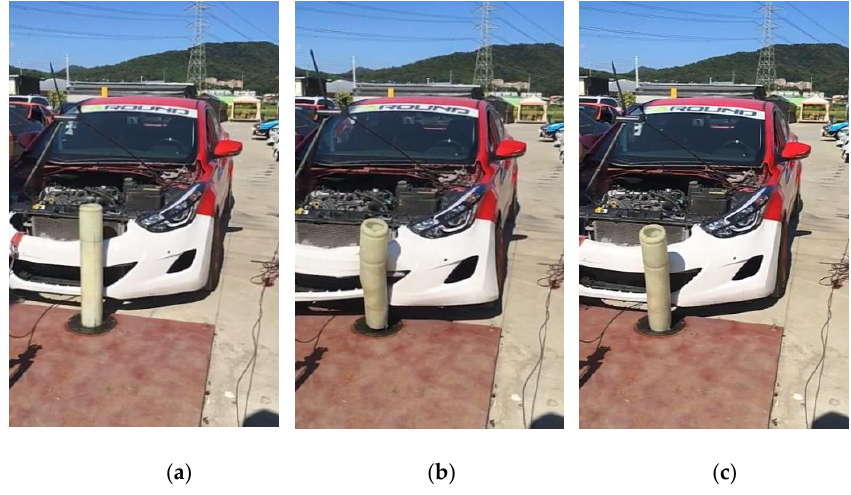
Figure 17. Pictures of an actual collision test with in-plane honeycomb bollard: ( a ) the immediate collision; ( b ) maximum deformation; ( c ) falling.